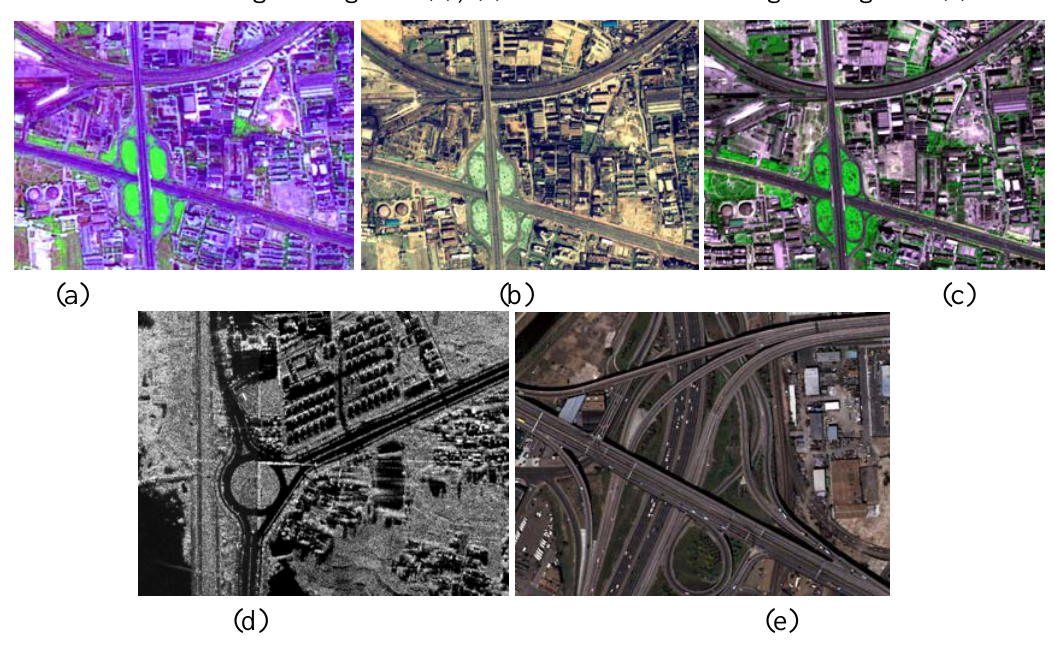
Figure 8. Typical roads on the images. (a) A subset of SPOT5 image in Figure 3(a); (b) a subset of IKONOS image in Figure 4(a); (c) a subset of QuickBird image in Figure